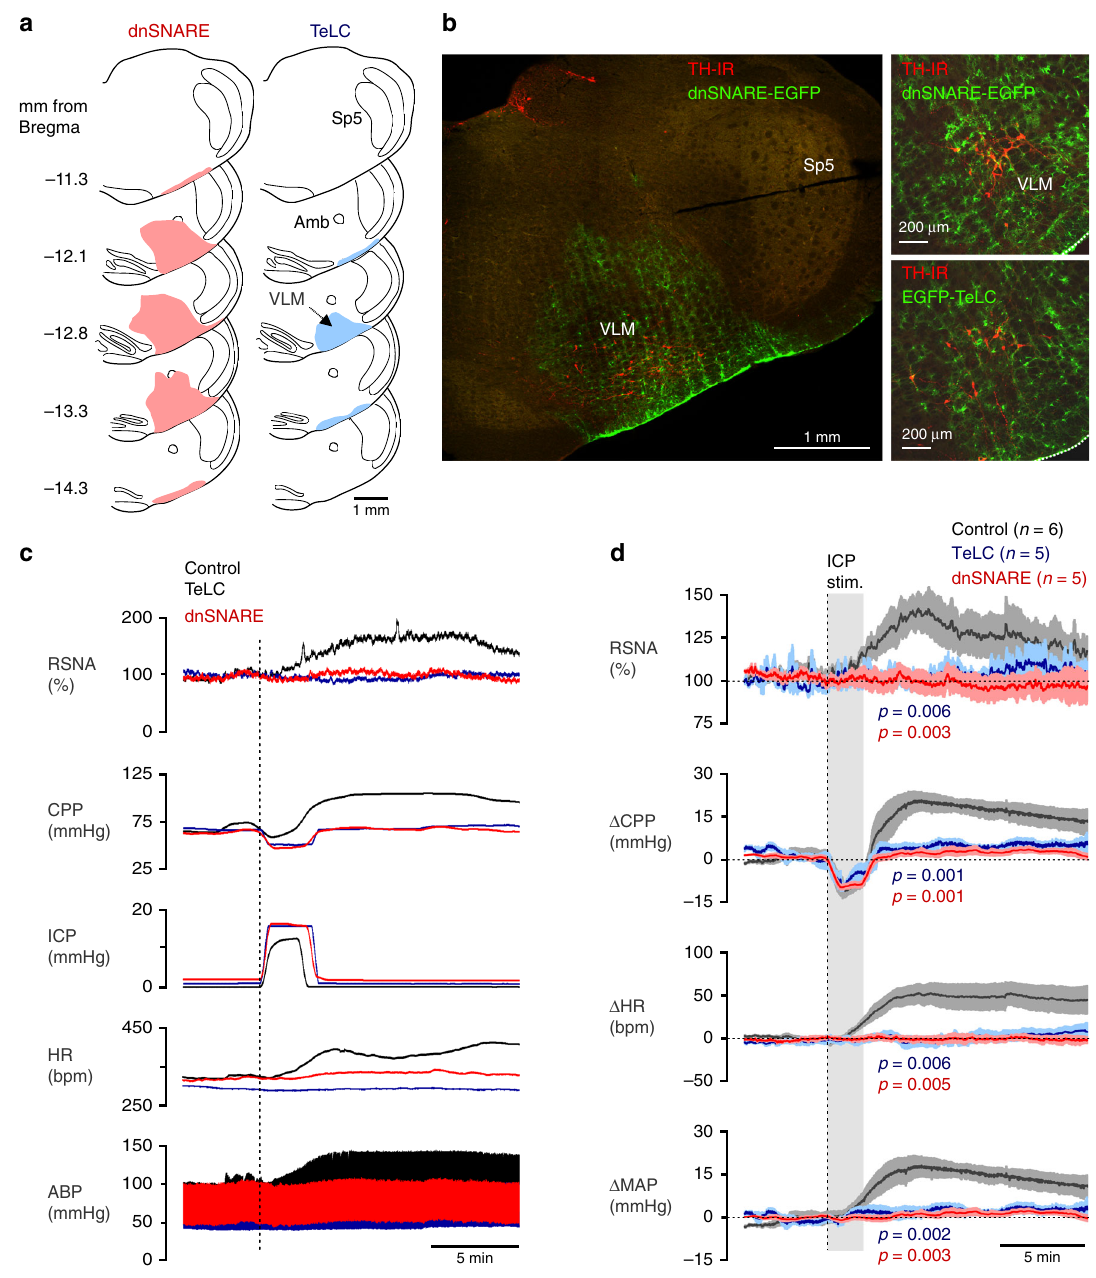
Fig. 4 Astrocytes mediate sympathetic and cardiovascular responses induced by decreases in brain perfusion. a Schematic illustration of the spatial extent of dominant-negative SNARE protein (dnSNARE) and tetanus toxin light chain (TeLC) expression following viral targeting of astrocytes residing within the sympathetic control circuits of the ventrolateral medulla oblongata (VLM). The extent of each transgene expression in the brainstems of all the experimental animals was histologically reconstructed (colored regions shown) from serial coronal sections. Amb, nucleus ambiguus. Sp5 spinal trigeminal nucleus. b Photomicrographs of coronal sections of the rat brainstem taken at low (left) and high (right) magni fi cation illustrating the expression of dnSNARE and TeLC in astrocytes residing within the sympathetic control circuits of the VLM. Astrocytes expressing the transgenes were identi fi ed by enhanced green fl uorescent protein fl uorescence (EGFP, green). Catecholaminergic sympathoexcitatory neurons are identi fi ed by tyrosine hydroxylase immunoreactivity (TH-IR, red). Scale bars: 1 mm (left), 200 μ m (right). c Representative raw traces and d summary data (means ± SEM) illustrating changes in renal sympathetic nerve activity (RSNA), cerebral perfusion pressure (CPP, calculated), heart rate (HR) and the arterial blood pressure (ABP) induced by increases in intracranial pressure (ICP) in animals transduced to express the control transgene (CatCh-EGFP), TeLC, or dnSNARE in the VLM astrocytes. MAP, mean arterial blood pressure. p- values, ANOVA. Source data are provided as a Source Data fi